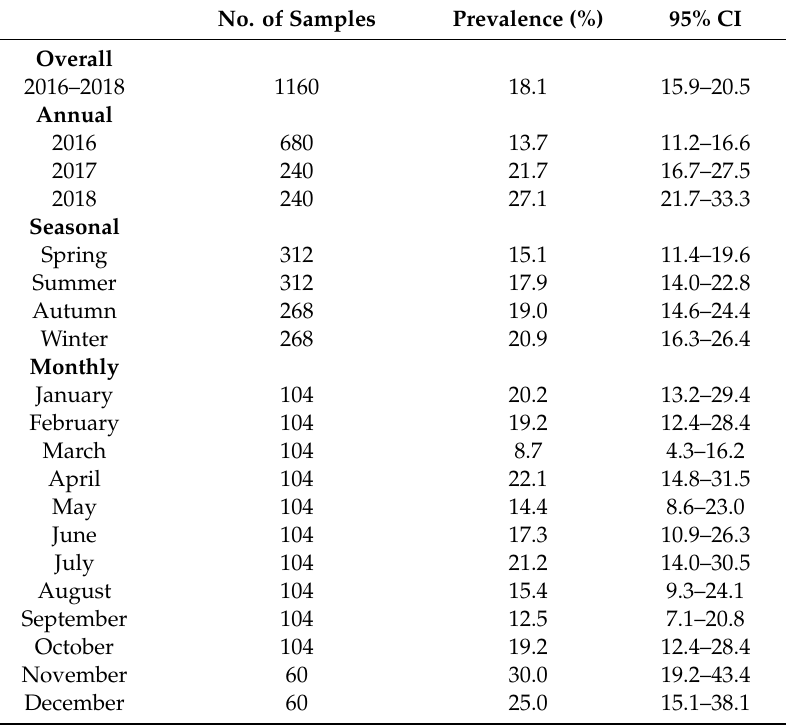
Table 1. Salmonella prevalence over